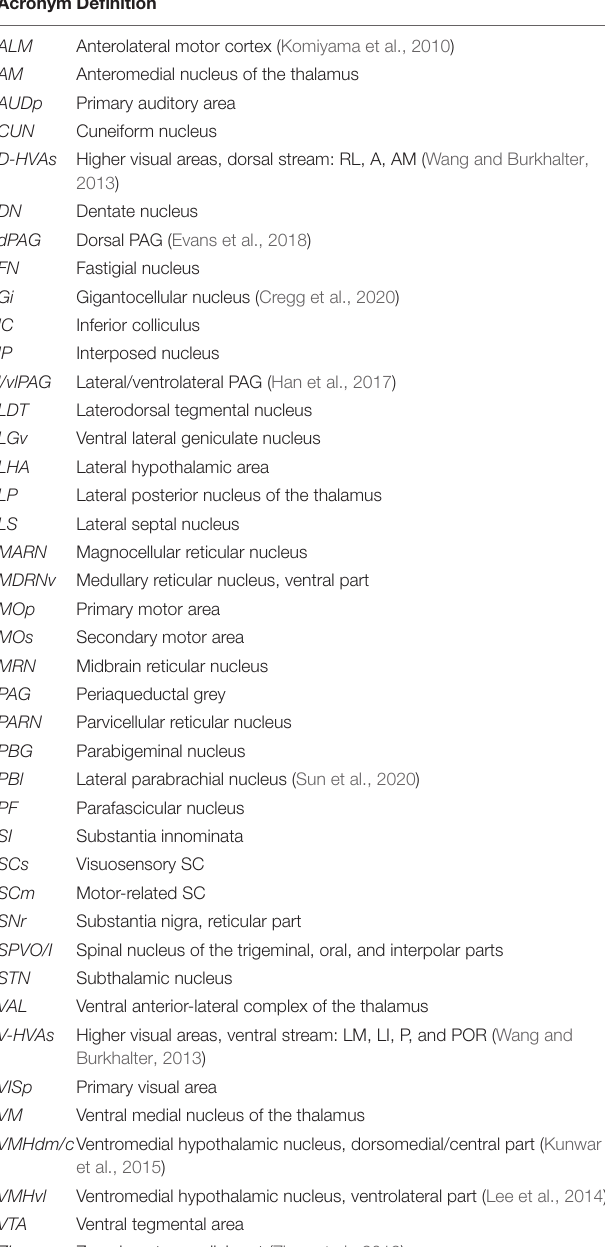
TABLE 6 | Acronyms and corresponding brain areas used in the